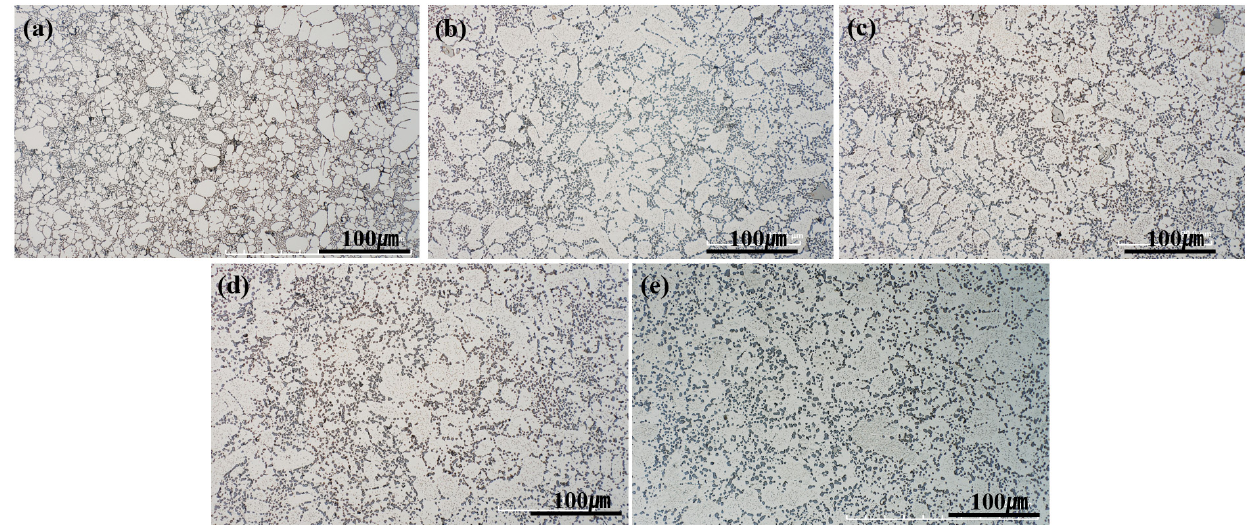
Figure 3. Optical micrographs of the specimens ( a ) as-cast, and after solution treatments at ( b ) 480 °C, ( c ) 500 °C, ( d ) 520 °C, and ( e ) 54 °C for 90 min.